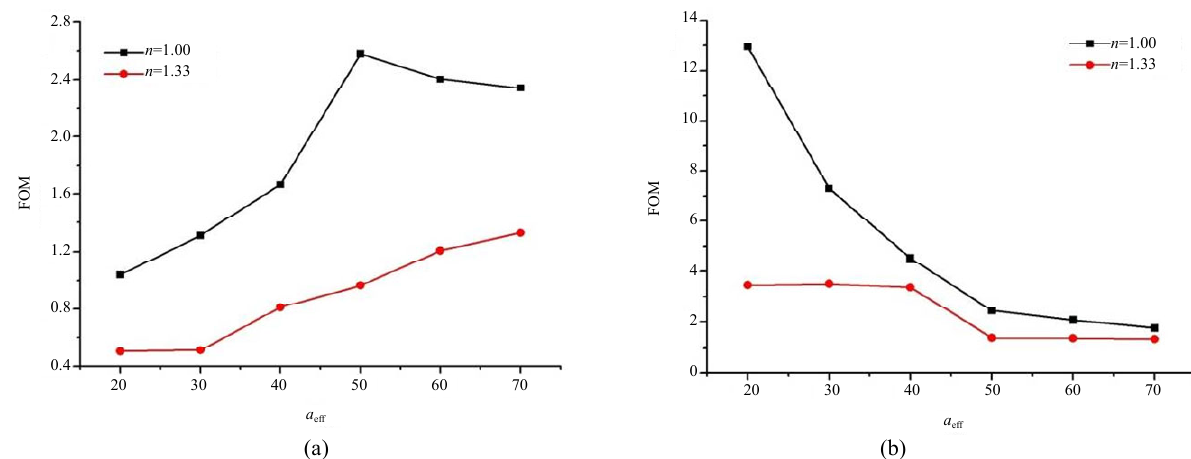
Fig. 10 Graph between the FOM and the size of (a) Ag 0.50 Fe 0.50 and (b) Au 0.50 Fe 0.50